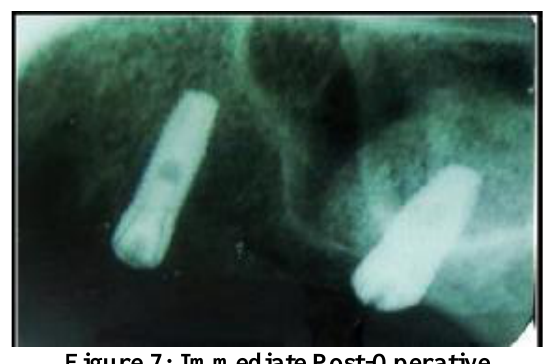
Figure 7: Immediate Post-Operative Periapical Radiographs Show the Amount of Figure 5: Initial Elevation and Assessment of Bone Graft and Implants inside the Sinus Membrane Integrity via Hydraulic Augmented Lift Maxillary Sinus. Pressure Test with Injection of 20 cc Normal Saline.